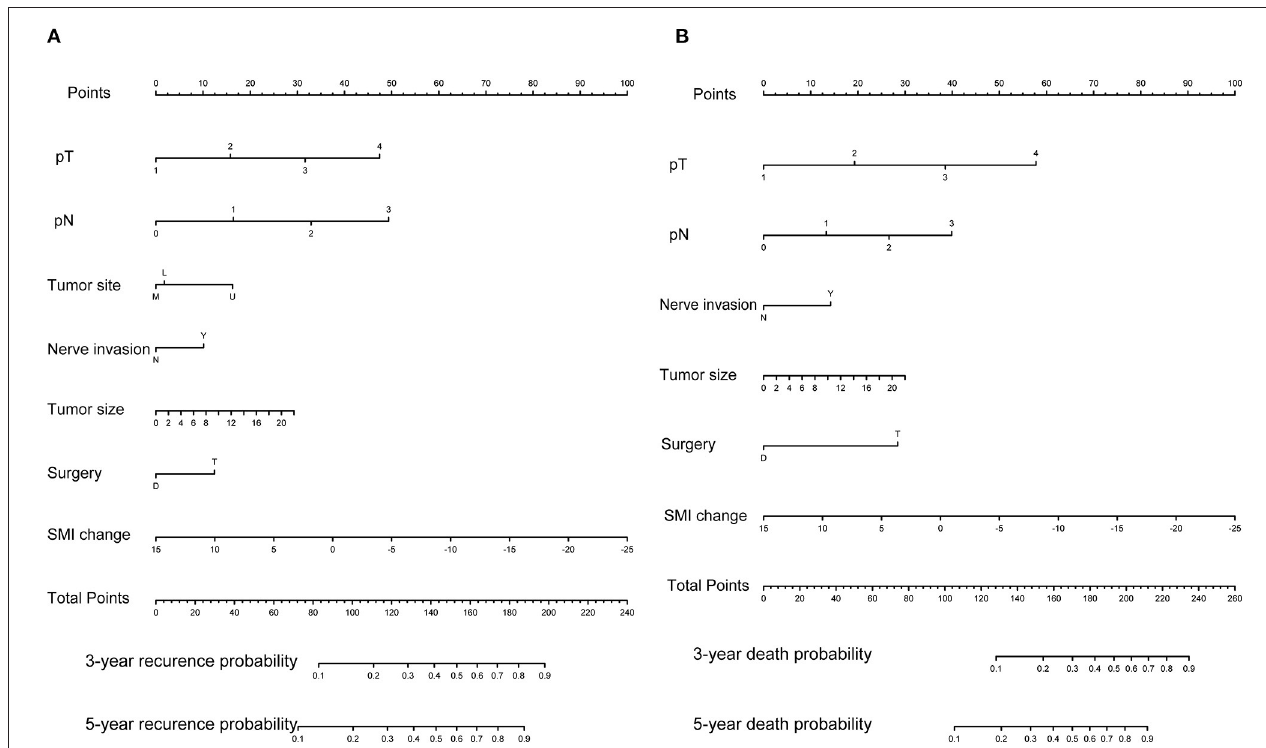
FIGURE 2 | Predictive nomograms. (A) Nomogram for predicting 3- and 5-year probability of disease recurrence. (B) Nomogram for predicting 3 and 5 month death probability.